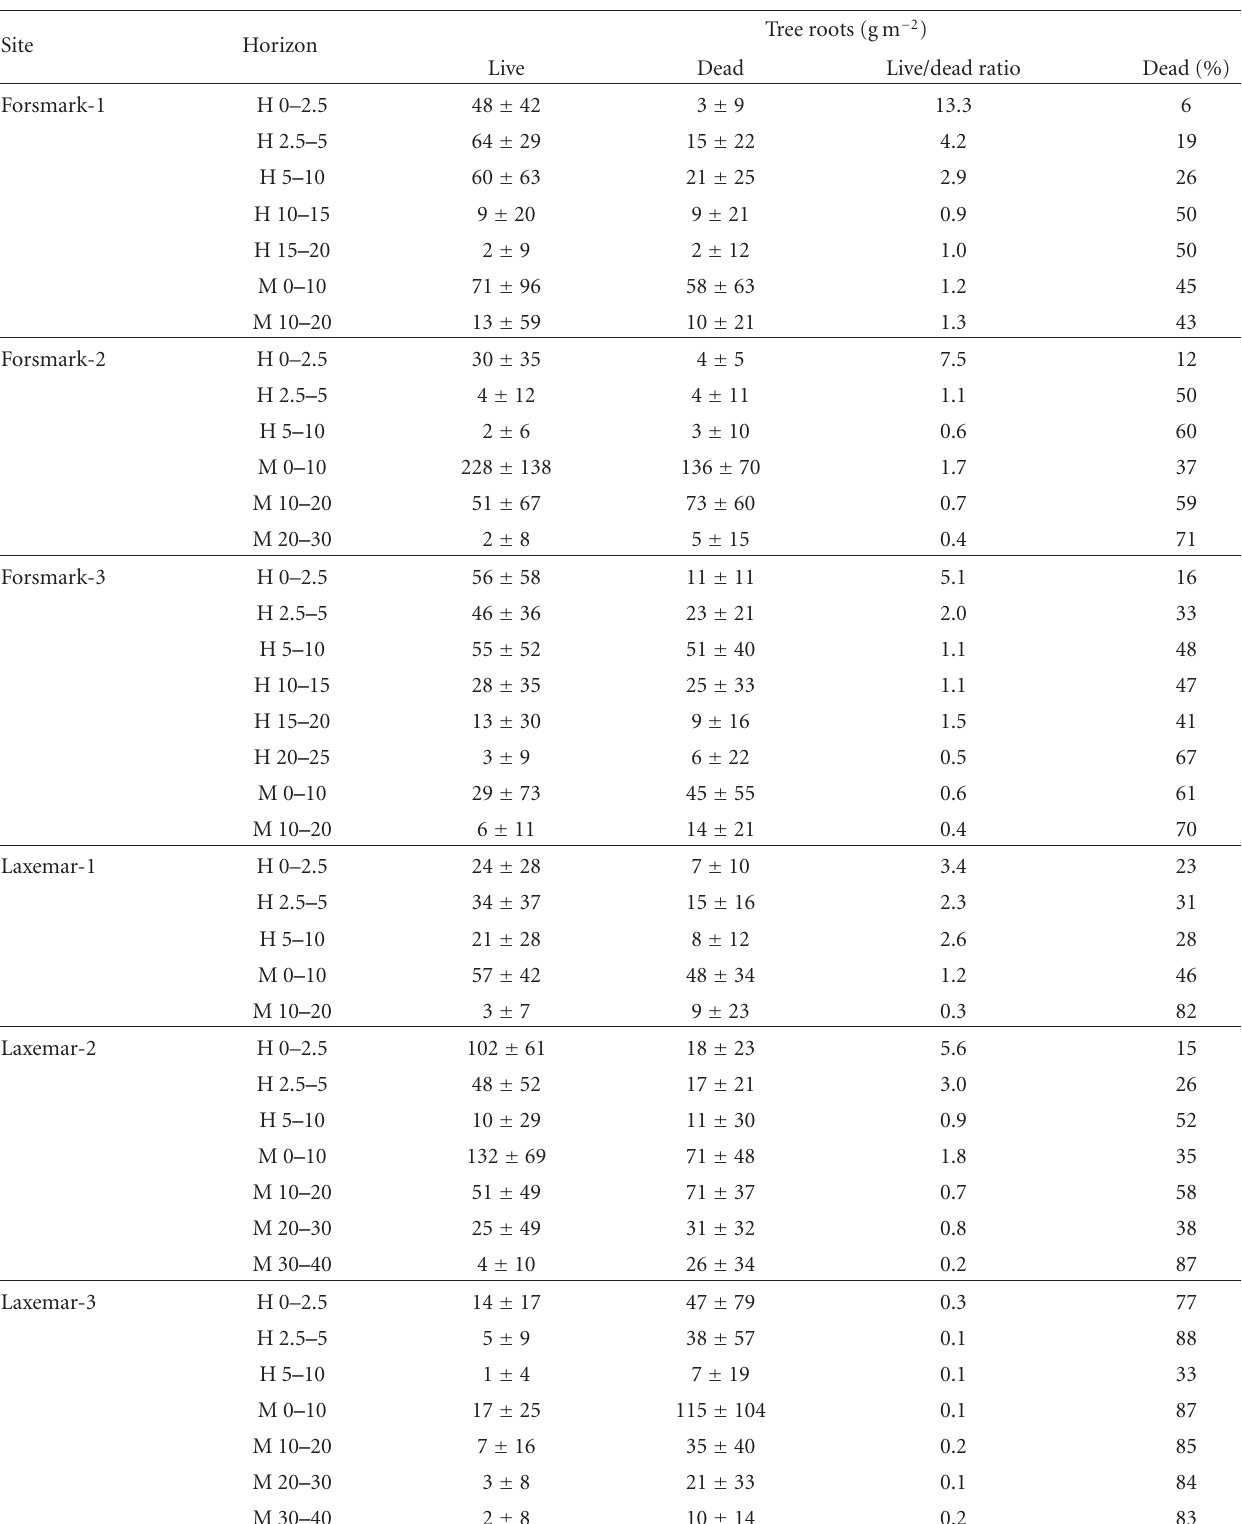
Table 2: The distribution of live and dead amounts of tree fine roots ( < 1mm in diameter), live/dead ratios, and dead (%) at di ff erent depths (H = humus; M = mineral soil) at the forest sites: Forsmark-1 (Coniferous, Calluna Empetrum type ), Forsmark-2 (Coniferous fern type) and Forsmark-3 ( Alnus swamp herb type) and Laxemar-1 (herb-rich oak forest), Laxemar-2 (Coniferous Vaccinium myrtillus type), and Laxemar-3 ( Alnus shore forest type) forest sites. The live/dead ratio is calculated from the mean amounts of live and dead tree fine roots. Estimates are given as mean values ± SD ( n =